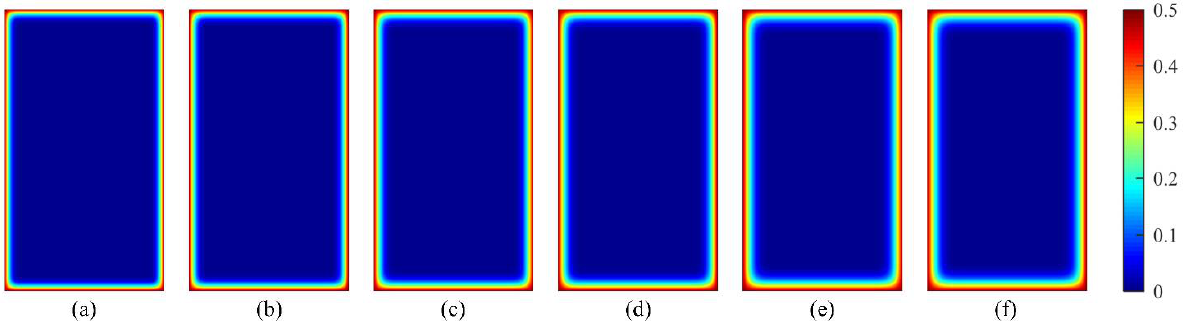
Figure 13. Simulation results (average value μ ) of chloride ion concentration in cross-section of fly ash concrete under different corrosion times: ( a ) t = 0.5 year; ( b ) t = 1 year; ( c ) t = 2 years; ( d ) t = 3 years; ( e ) t = 6 years; ( f ) t = 8 years.